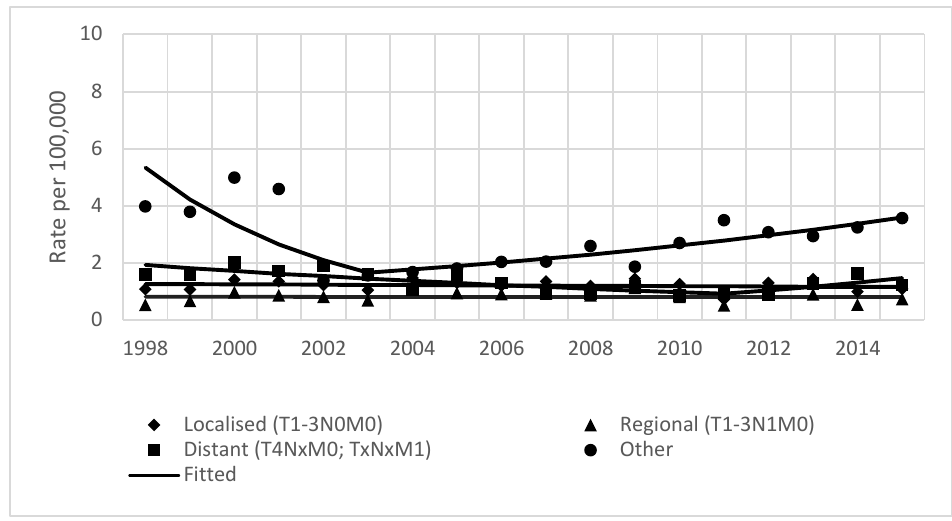
Figure 4. Age-standardized incidence rates of pancreatic cancer by stage of disease in Lithuania from 1998–2015. Both sexes.